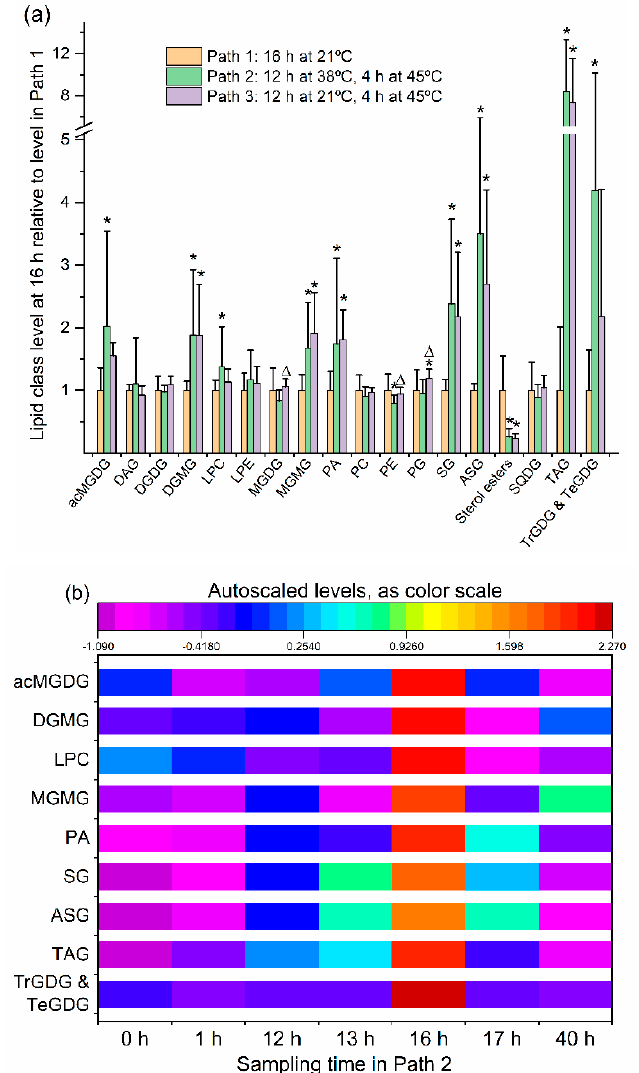
Figure 2. Levels of lipid head group classes in Arabidopsis leaves at the end of the heating treatment, compared to plants at 21 °C, and Path 2 lipid class time course. ( a ) Levels of lipid head group classes at the end of the heating treatment (16 h time point) in Path 2 (12 h at 38 °C and 4 h at 45 °C) and Path 3 (12 h at 21 °C and 4 h at 45 °C), relative to level at same time point in Path 1 (16 h at 21 °C). Asterisks indicate a significant difference in lipid level in Path 2 or 3 (by comparison with Path 1). Triangles indicate a difference of Path 3 from Path 2 . Differences were evaluated by one-way ANOVA with Tukey’s multiple comparisons test, adjusted for FDR. A p value < 0.05, after correction for FDR, was considered significant. Error bars indicate standard deviation. ( b ) Heat map for lipid samples from the time course listing the nine lipid classes significantly increased in Path 2, based on autoscaled values for each lipid (see Materials and Methods).